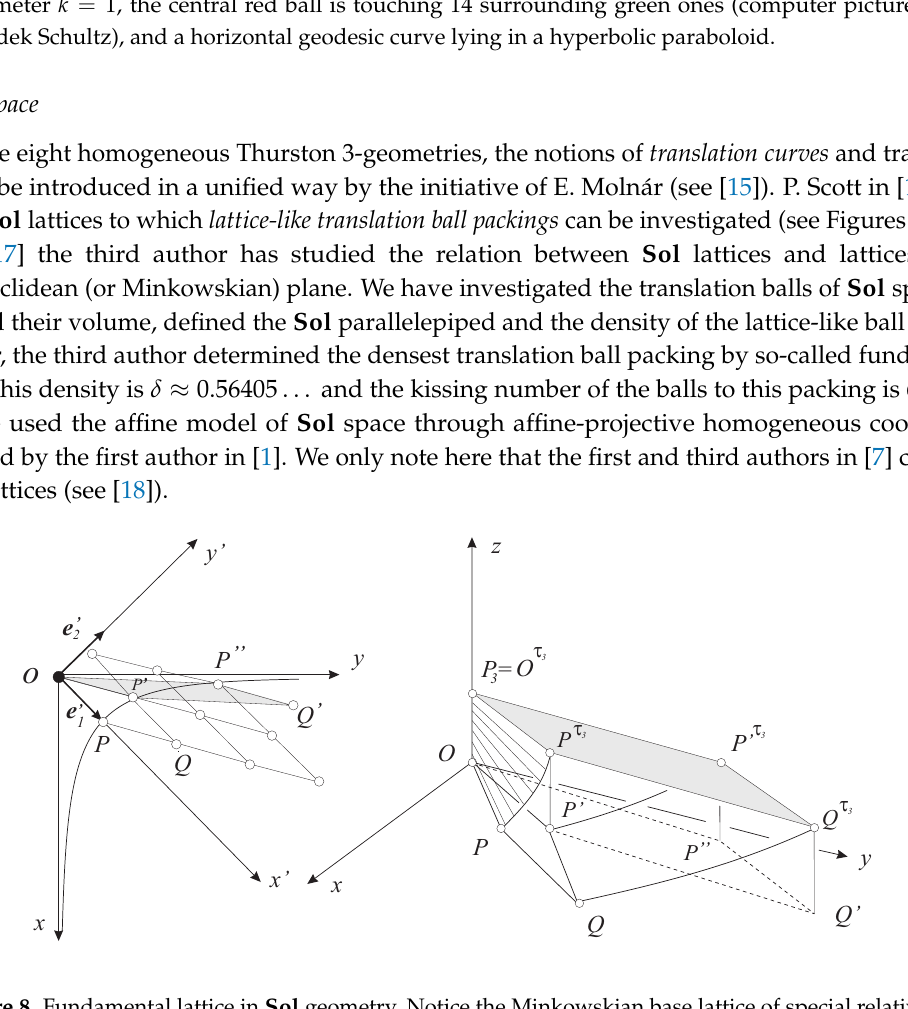
Figure 8. Fundamental lattice in Sol geometry. Notice the Minkowskian base lattice of special